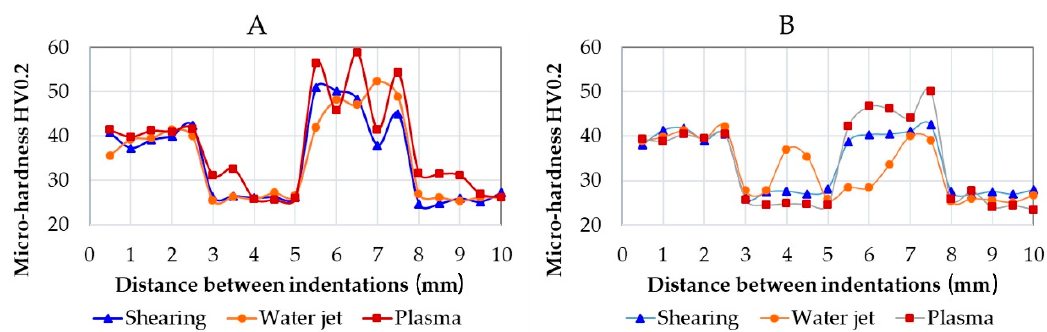
Figure 14. Graphical representation of the micro-hardness measured in TIG ( A ) and MIG ( B ) speci- mens.